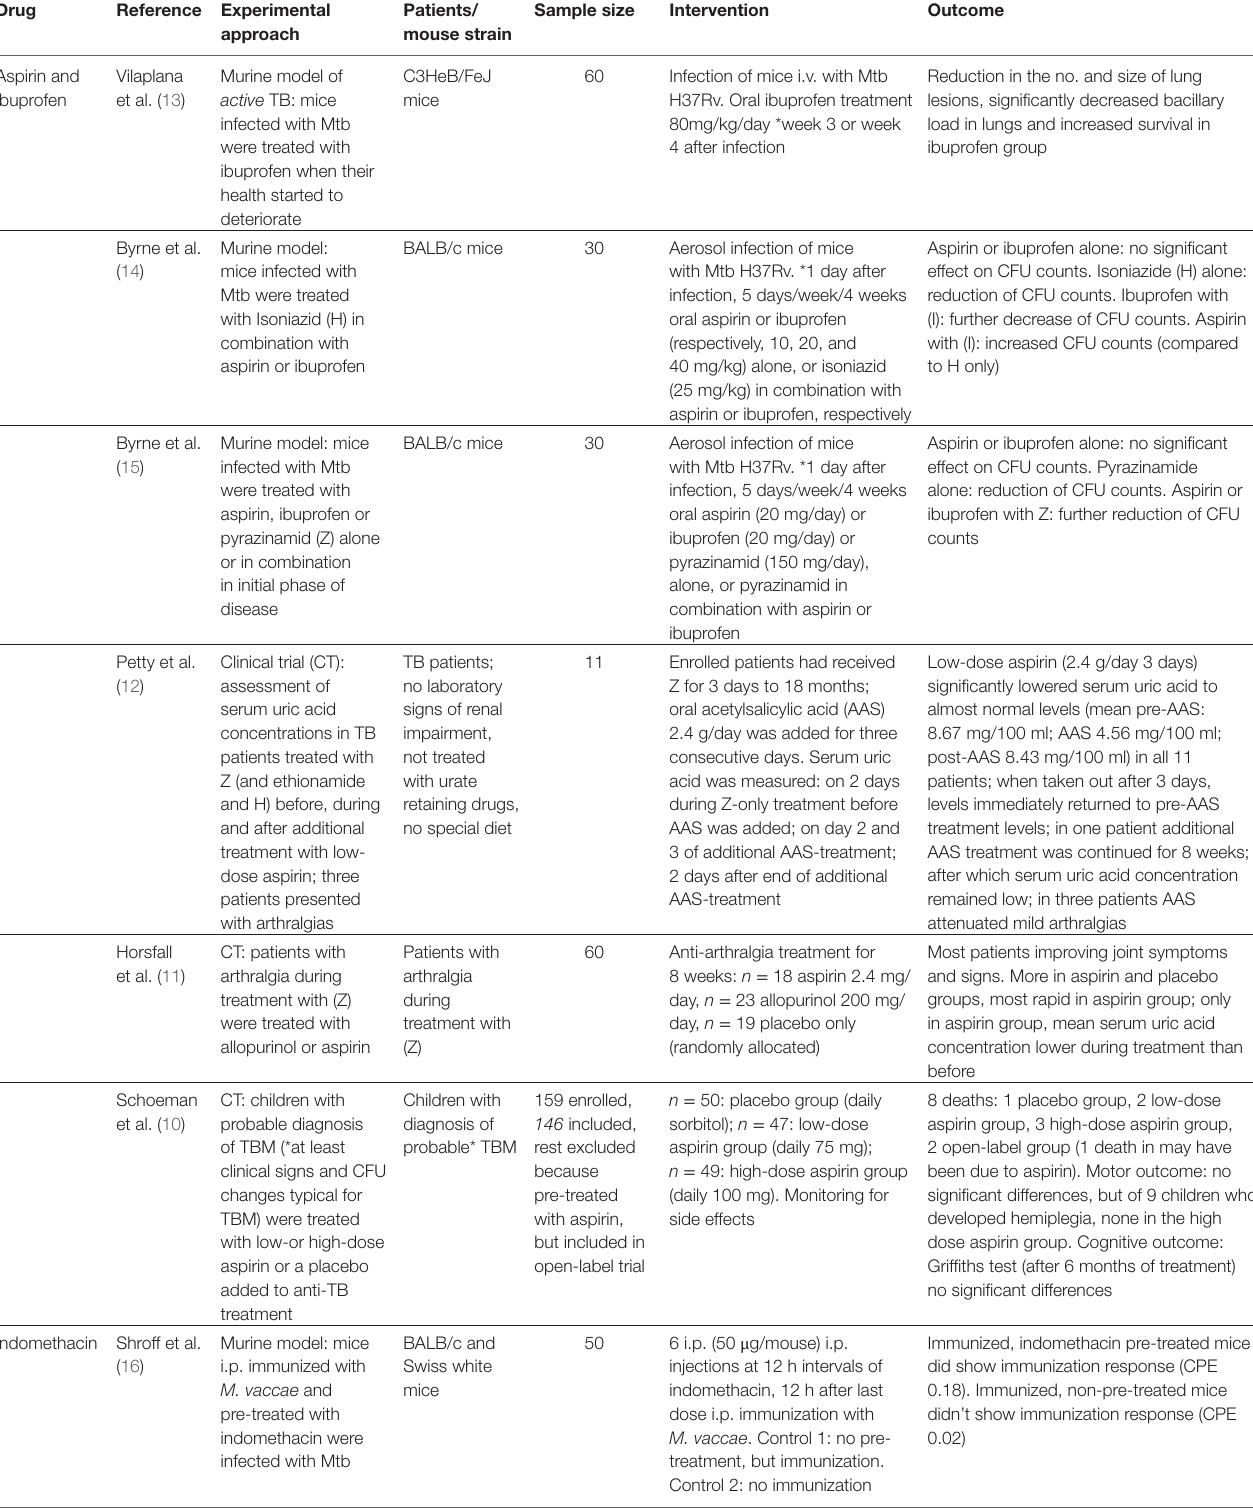
TAbLe 1 | An overview on the data acquisition from relevant studies for systematic review.